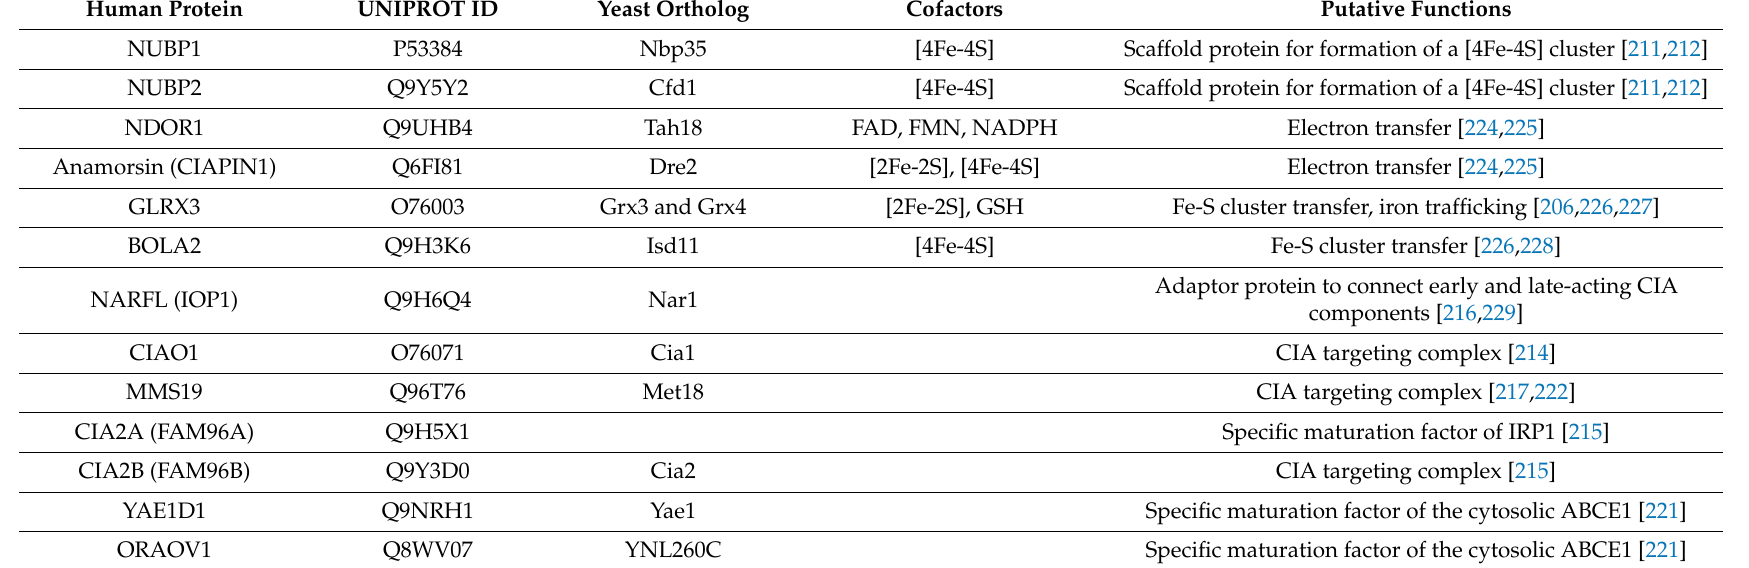
Table 2. Proteins involved in CIA